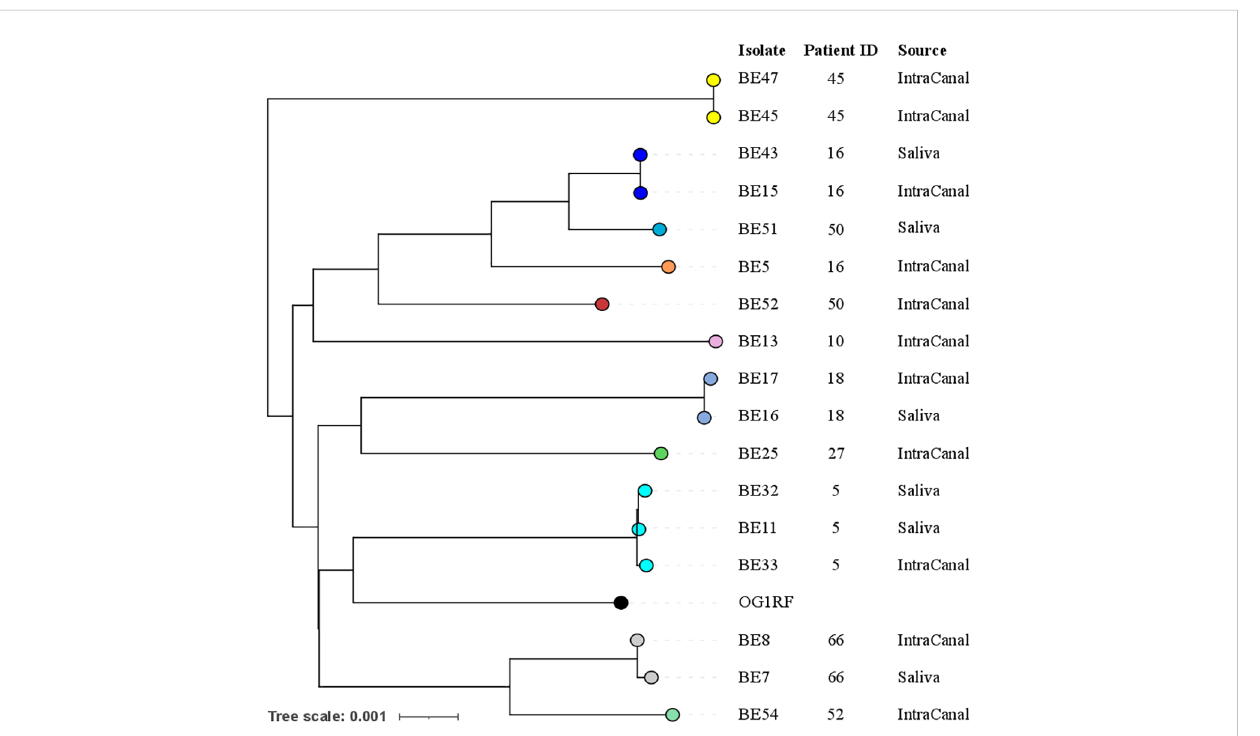
FIGURE 1 Phylogenetic relationships among E. faecalis isolates. Different colors indicate different genomic clusters: ten population clusters were identi fi ed using core genome sequences, 5 clusters contain a single genome, while another 5 contain either 2 or 3 genomes, notably all coming from the same patient. The phylogenetic tree was generated based on whole genome sequences with branch lengths indicating the number of nucleotide substitutions per site (scale bar). Patient ID and source of the sample are indicated on the right. The genome of the reference laboratory strain OG1RF was used as an